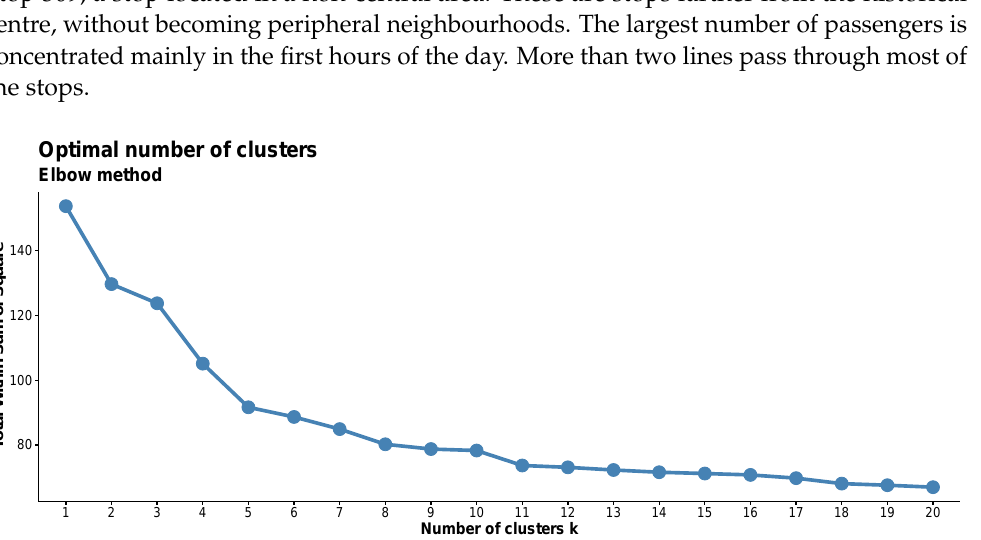
Figure 4. Graphical representation of elbow method to determine the optimal number of clusters, using the ACF